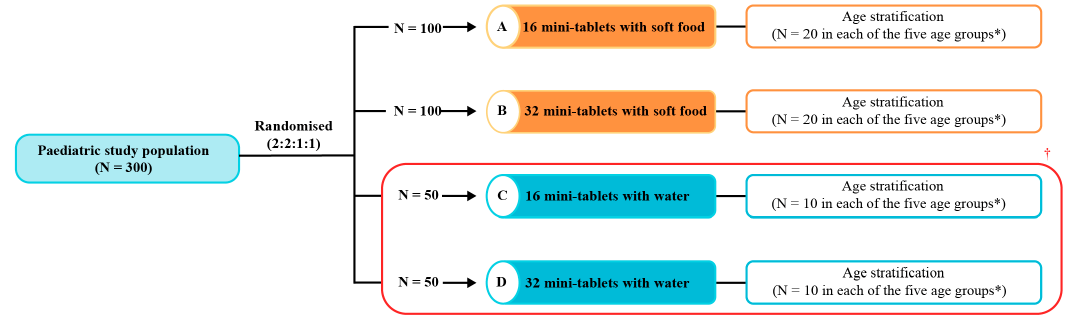
Figure 2. Study design. In total, 300 children were screened, and all of these children were random- ised and completed the study. * The age groups were 2– ˂ 3 years, 3– ˂ 4 years, 4–<5 years, 5–<6 years, and 6–<7 years. † Groups receiving mini-tablets with water (groups C and D) were combined in the statistical analysis. N, number of evaluable subjects.